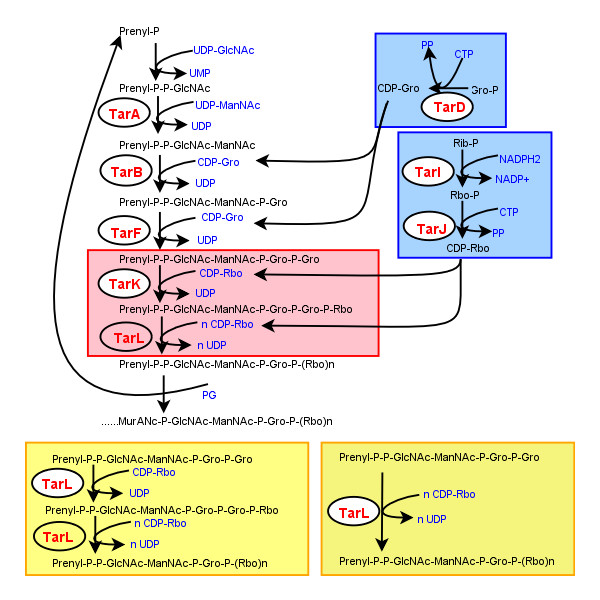
The tar pathway in S. aureus. The top panel is the tar pathway in B. subtilis W23 [1], In S. aureus The TarK in B. subtilis is either replaced by TarL or merged with TarL as a one step (bottom blocks).